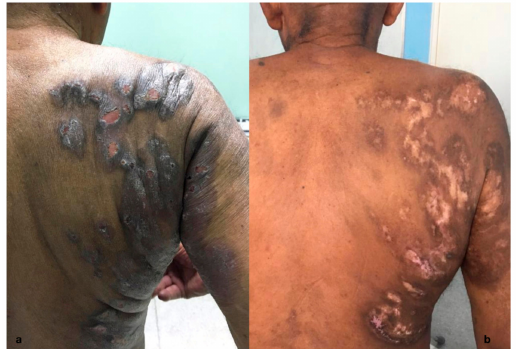
Figure 2. Clinical presentation of ALK- pcALCL with extensive ulcerated plaques located on the trunk and upper arms ( a ). Resolution of skin lesions, with central scarring and depigmentation after treatment ( b